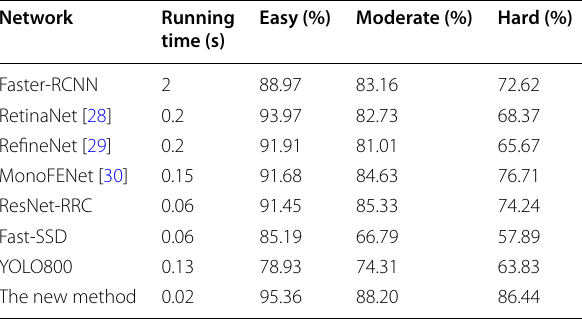
Table 3 Performance comparison of 2D object